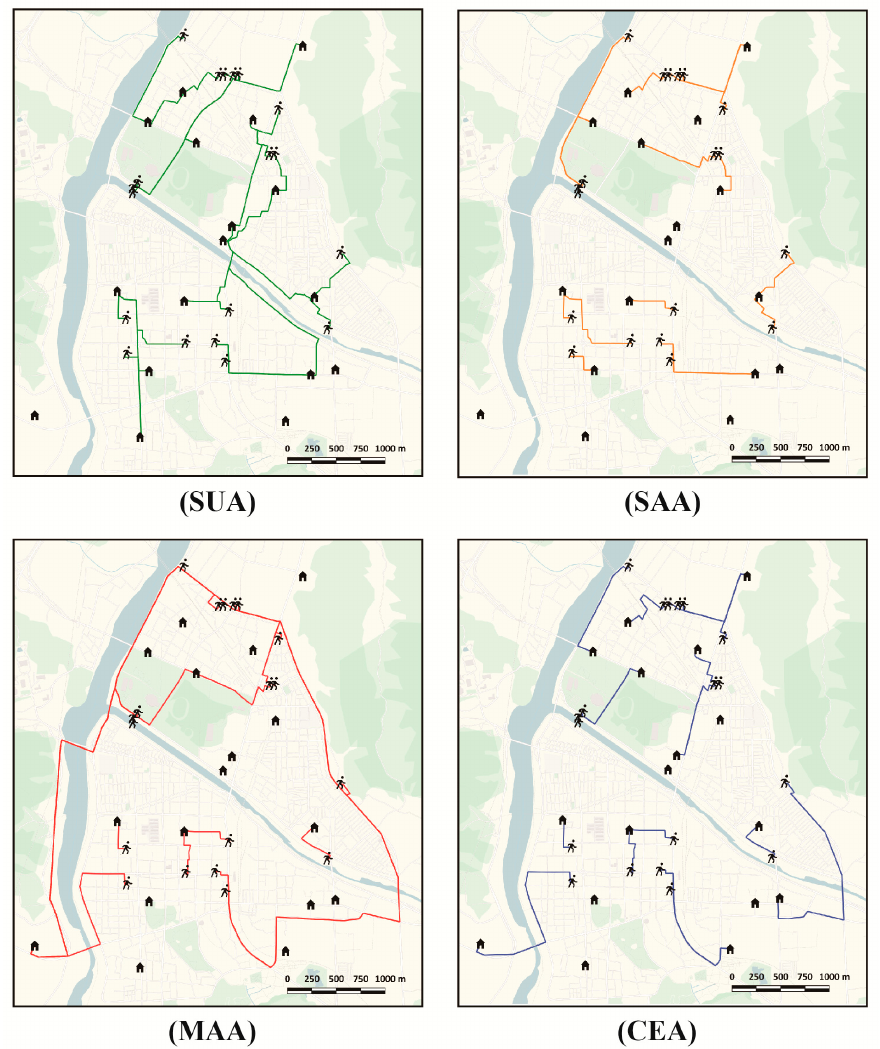
Figure 9. Examples of route change for each analysis. SAA provides more direct paths to shelters than SUA, by eliminating trips to multiple shelters. Pedestrians mostly use outer roads through MAA.